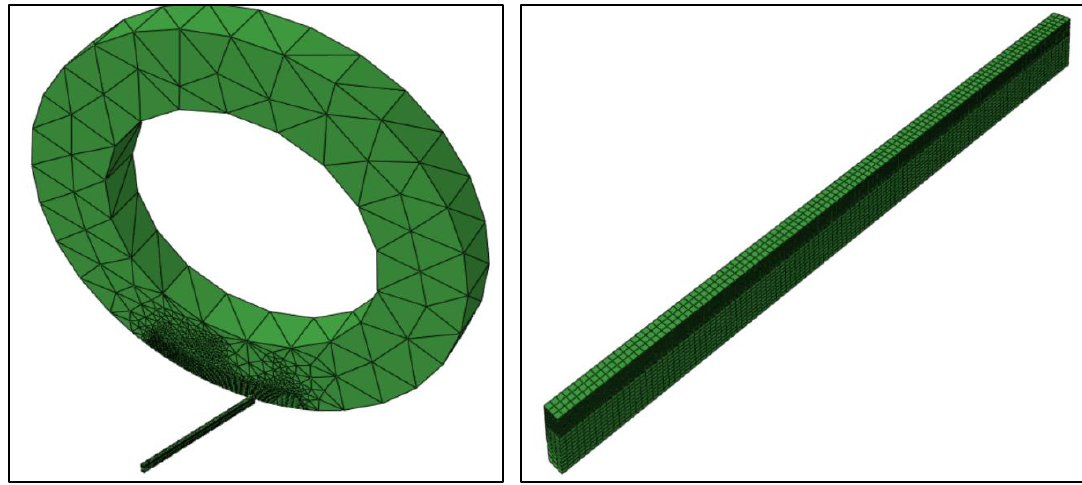
Figure 1. Workpiece and tool interaction (left) and workpiece mesh (right).